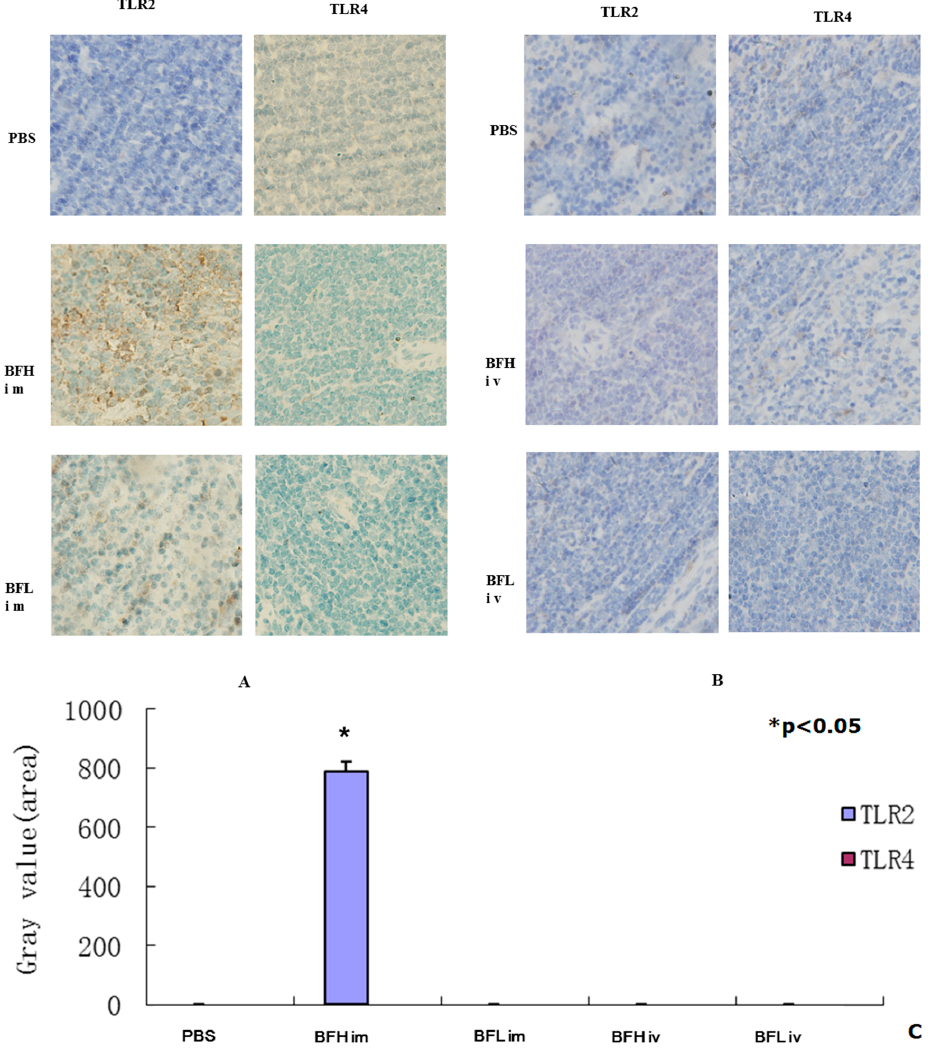
Figure 4. Immunohistochemical (IHC) assay of the spleen of BALB/c mouse via IM and IV treatment with BF-rTK ( n = 6). ( A ) IM injection of a high dose of BF-rTK induced TLR2 significantly increased expression and TLR4 had no detectable variation; ( B ) TLR2 and TLR4 were undetectable treated with BF-rTK via IV with both high and lower doses of BF-rTKs. The slices were detected three times with duplicate technical replicates; ( C ) Quantitative analysis of TLRs (* p < 0.05).